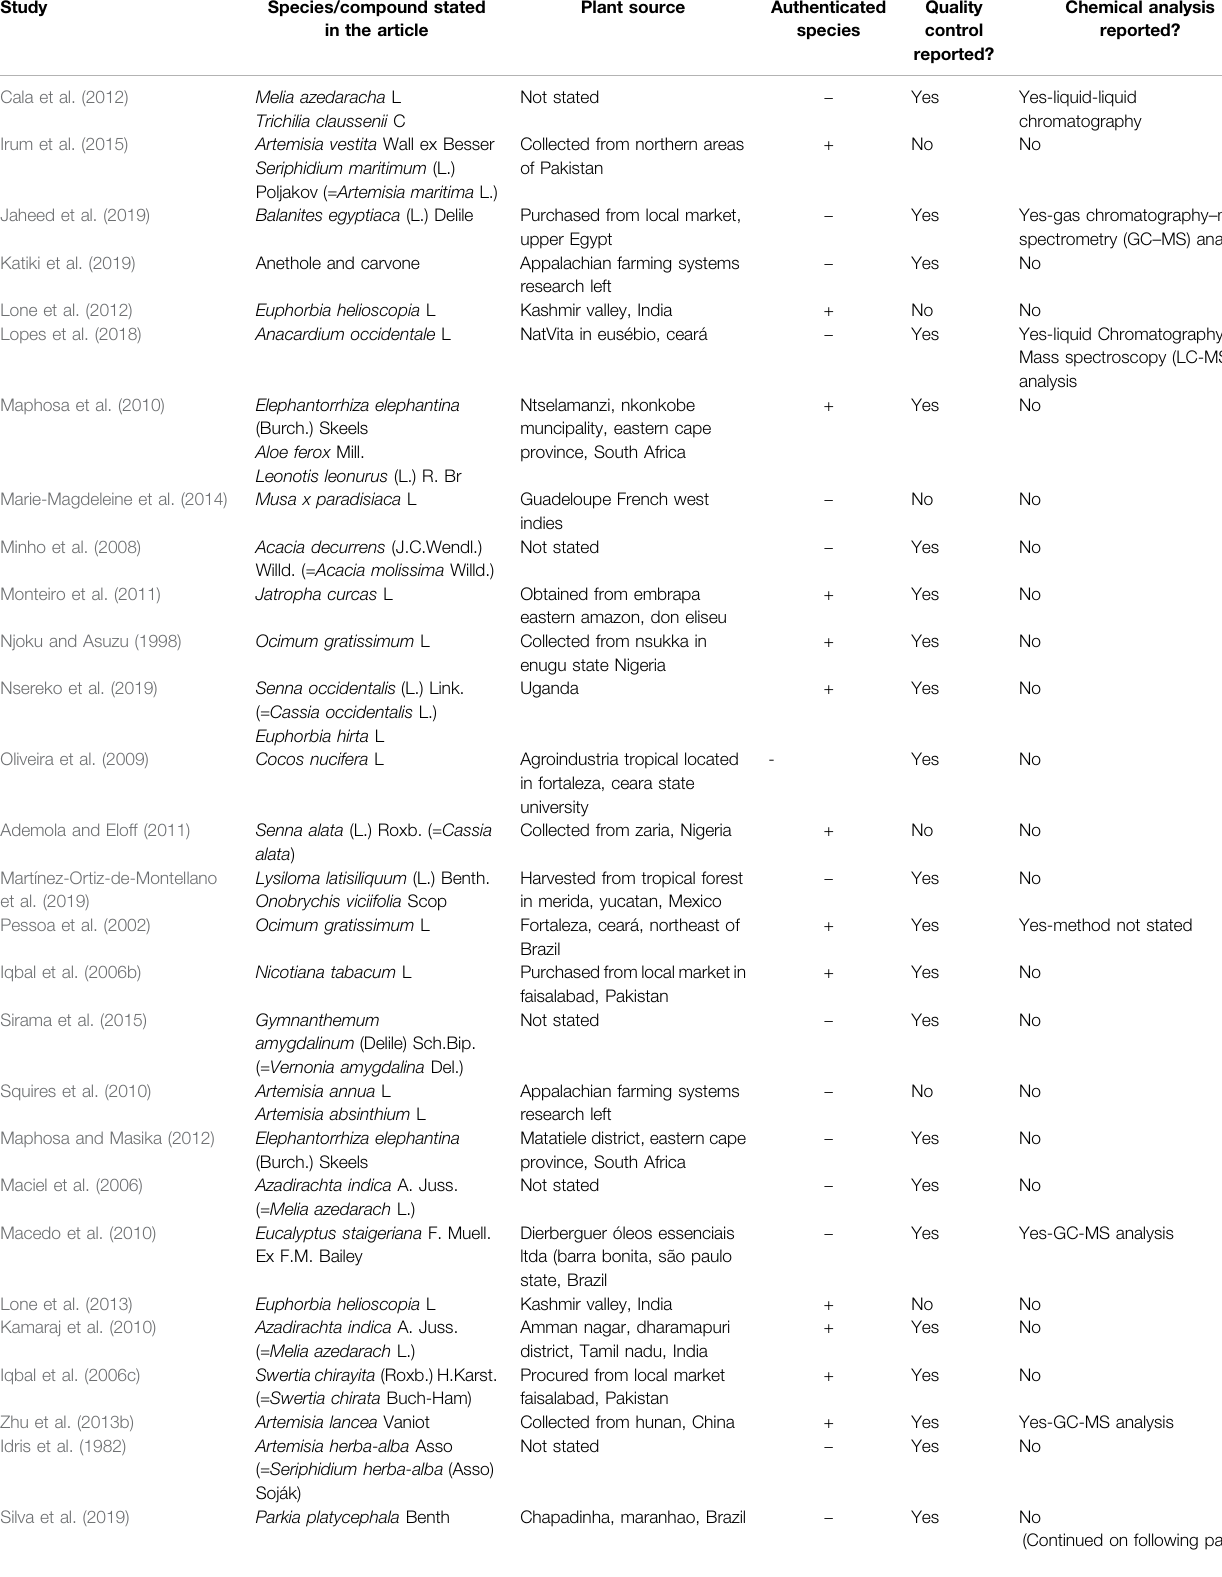
TABLE 1 | Quality assessment of the articles selected for this systematic